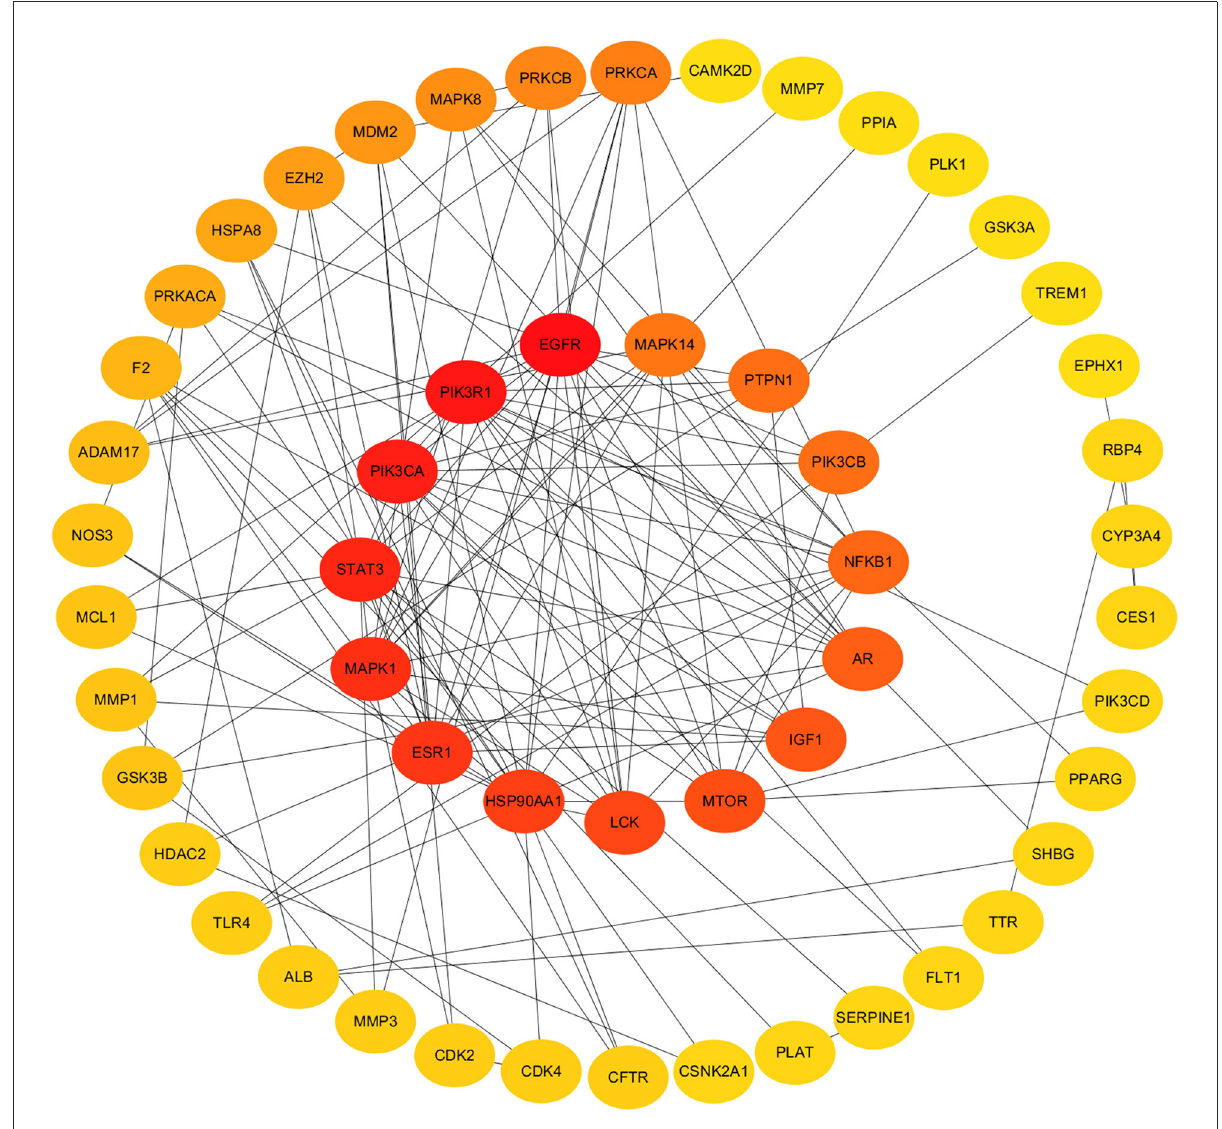
FIGURE4 Protein–protein interaction networks and hub target genes. Hub target genes revealed in inner track. The darker the color, the higher the score.